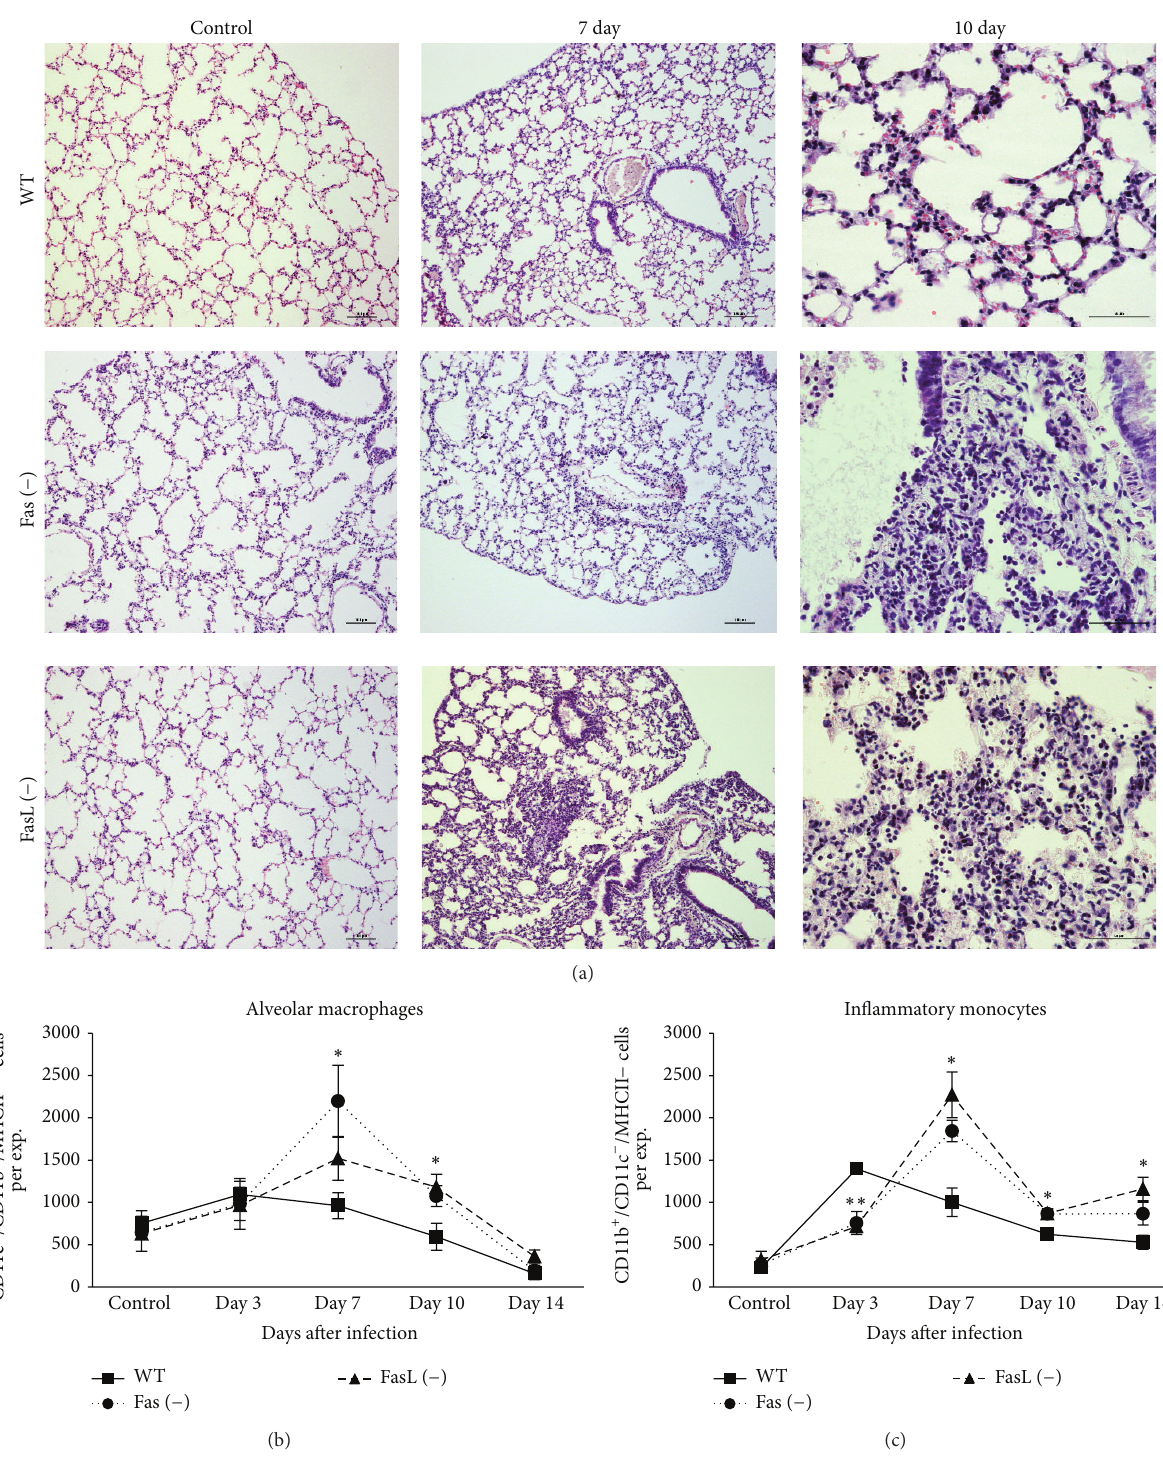
Figure 2: Lack of Fas or FasL leads to disturbances in the inflammatory response. (a) Histological analysis of lungs isolated from ECTV- infected Fas ( − ), FasL ( − ), and WT (C57BL/6) mice at 7 and 10 days of infection and uninfected controls. The nuclei were counterstained with Harris haematoxylin (violet) ( × 40 and 100). Total counts of alveolar macrophages (b) and inflammatory monocytes (b) in cell suspensions prepared from the lungs isolated from Fas ( − ), FasL ( − ), and WT (C57BL/6) mice at 3, 7, 10, and 14 days of ECTV infection and from control, uninfected mice. The bars represent the mean from 5 separate experiments ± SEM. ∗ Significant differences with 𝑃 ≤ 0.05 and ∗∗ 𝑃 ≤ 0.01 in comparison to wild-type